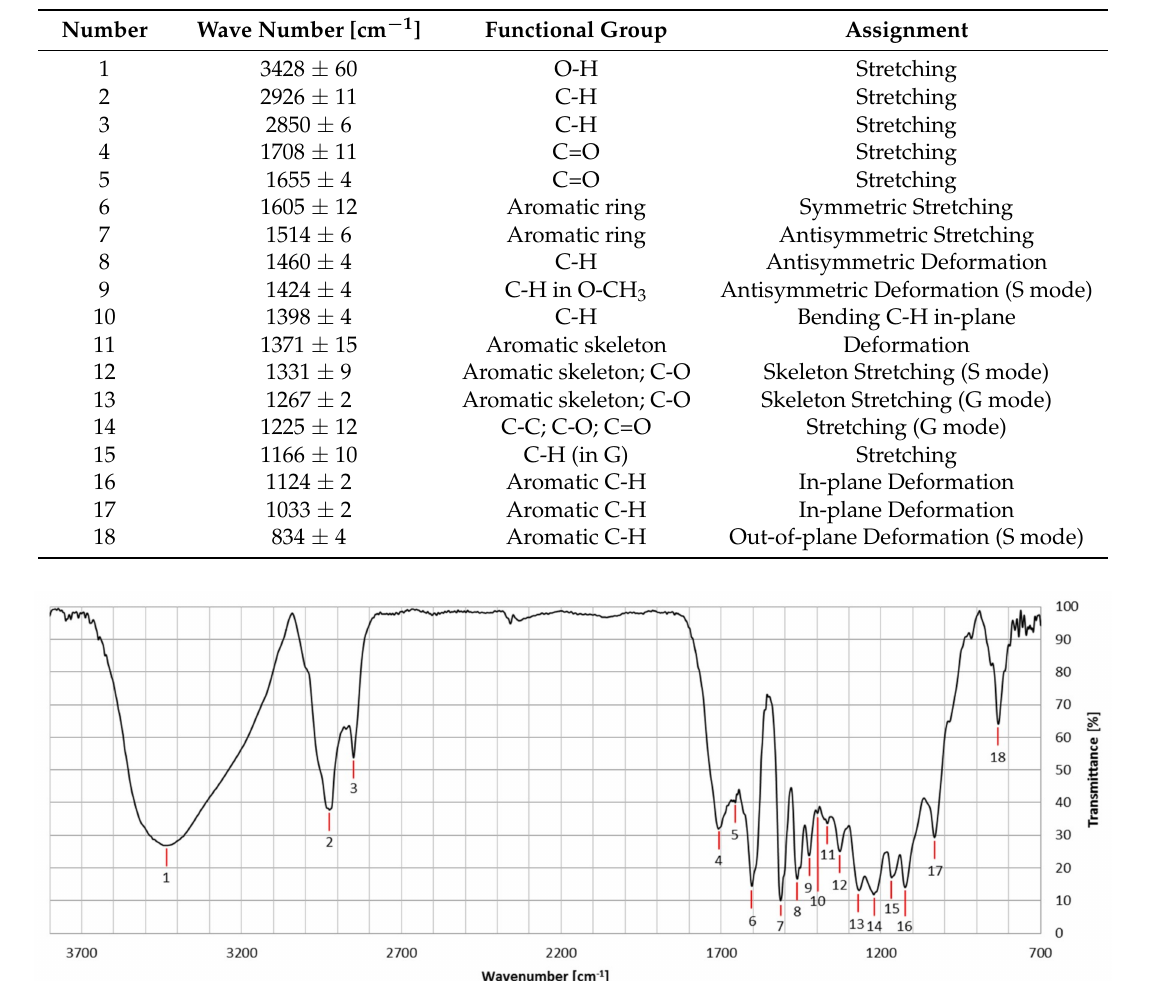
Table 3. FTIR signals and corresponding assignment for a lignin isolated from M. x giganteus (Gig17, stem/leaf mixture).